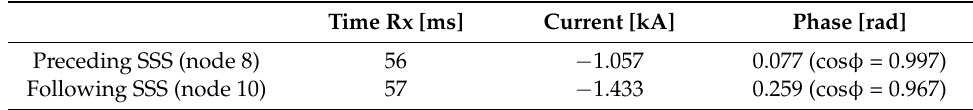
Table 3. Node 9 received current module/phase measurements.